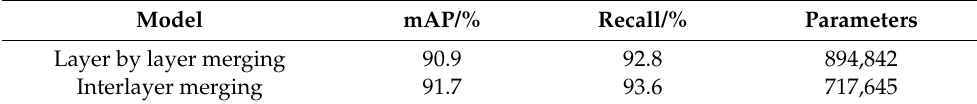
Table 4. Effect comparison of “interlayer merging” and “layer by layer merging”.